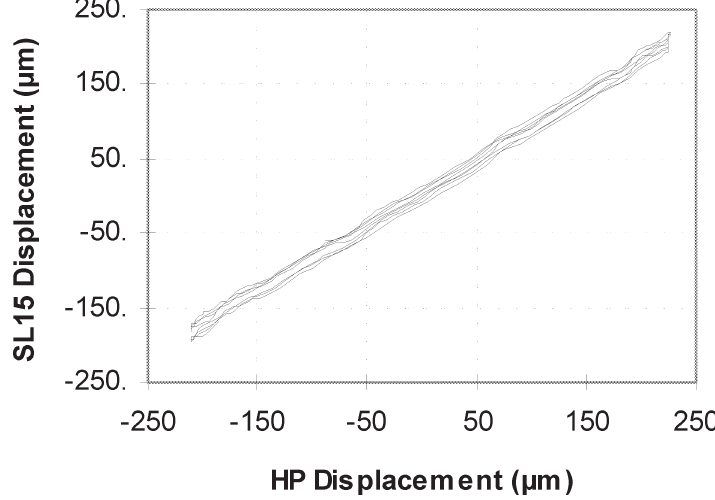
Fig. 6. Displacement measured by the photodetector vs HP laser interferometer.